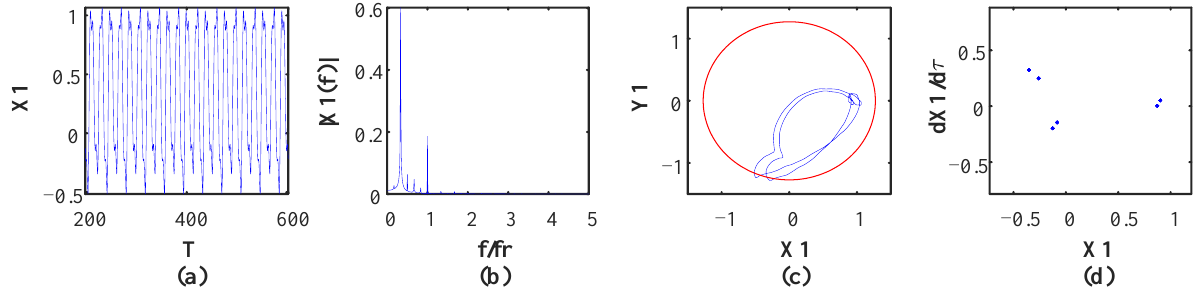
Figure 10. Numerical integration results at ω = 1184 rad/s: ( a ) Time domain waveform; ( b ) Frequency spectrum; ( c ) Shaft orbit; ( d ) Poincaré map.